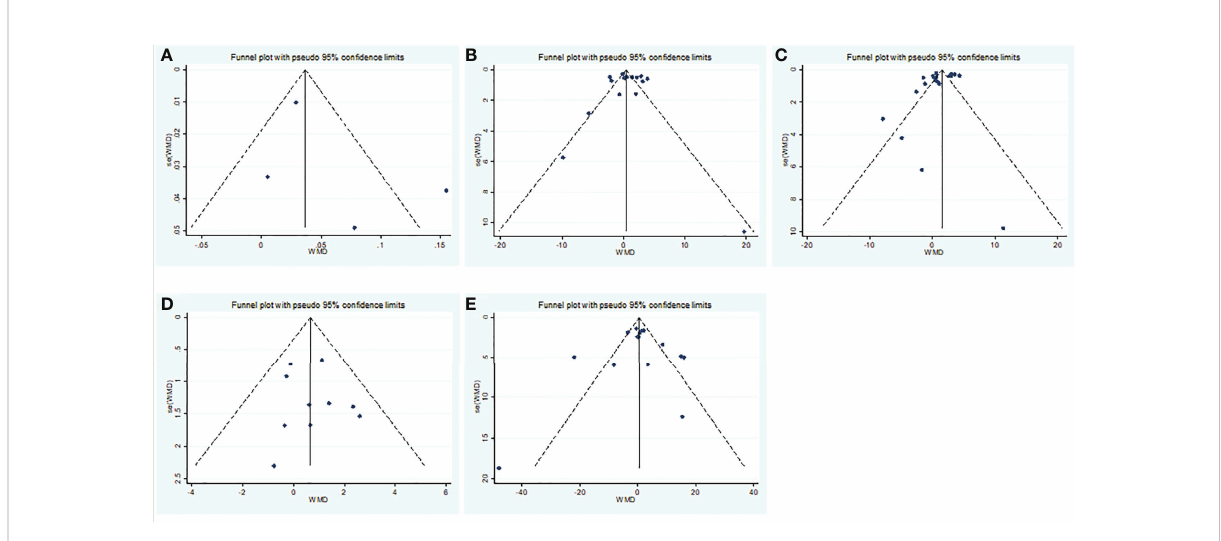
FIGURE 7 Publication bias funnel plots of the WMD for (A) TT, (B) FSH, (C) LH, (D) PRL, (E) E 2 and COVID-19.